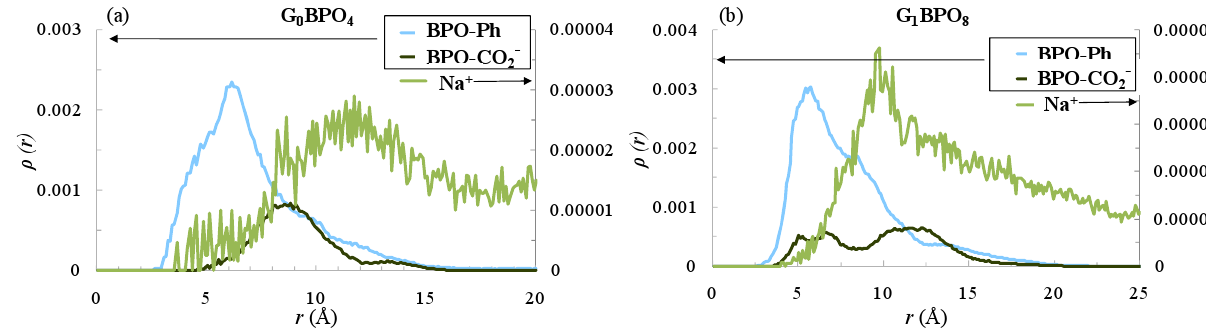
− is 2 − ) and the rest of the 2